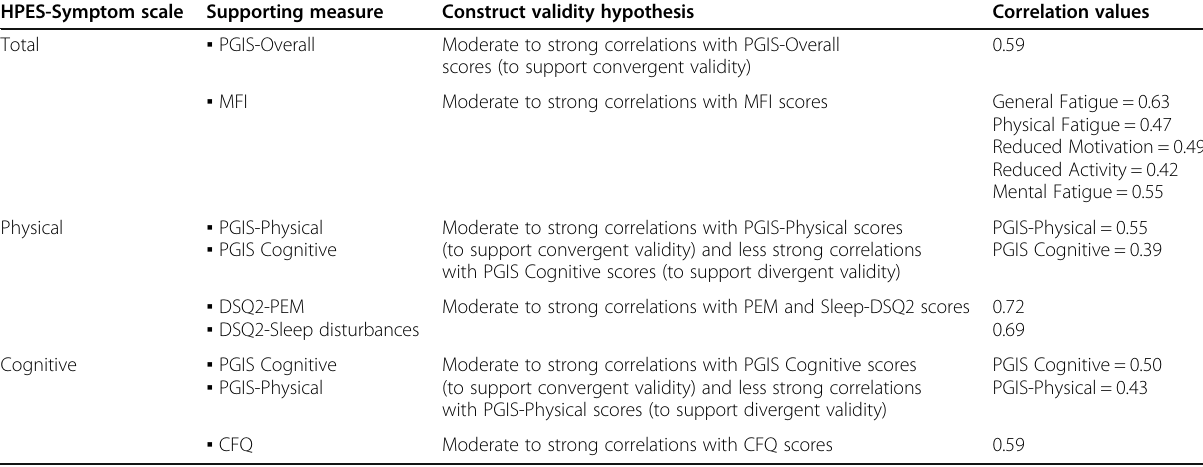
Table 3 Observational study construct validity hypotheses for HPES-Symptom at baseline HPES-Symptom scale Supporting